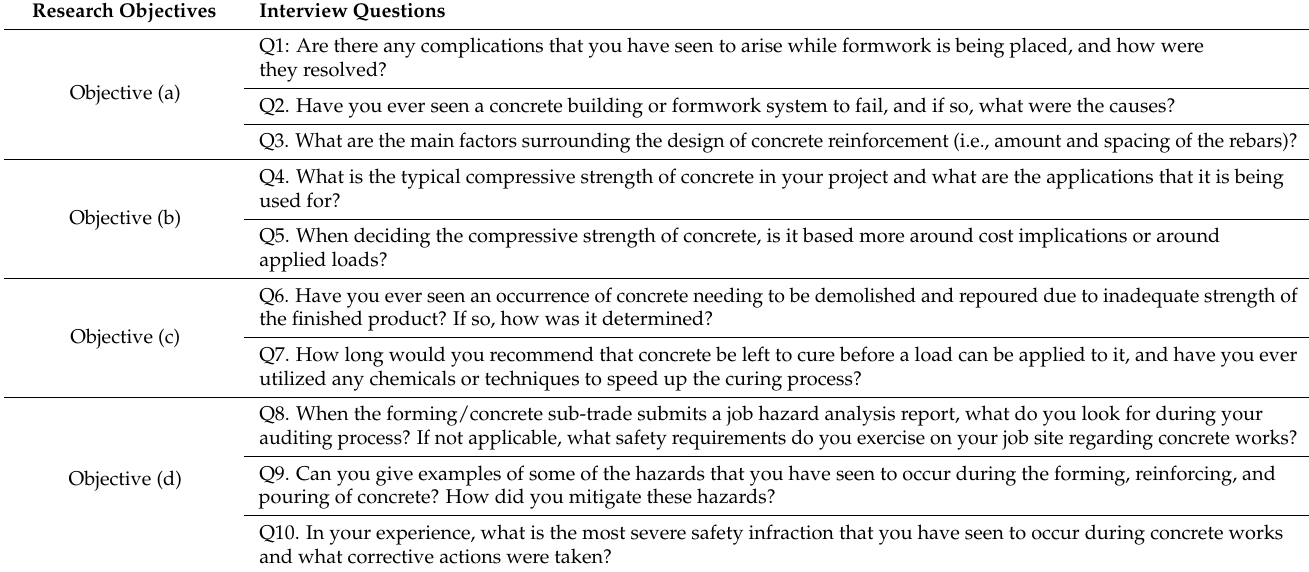
Table 1. Interview questions designed based on research